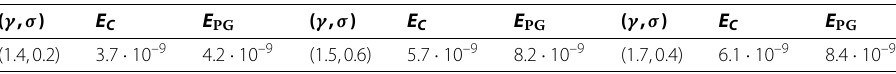
Table 4 Maximum pointwise error of Example 3 ( M = 7) ( γ , σ ) E C E PG ( γ , σ ) E C (1.4,0.2)